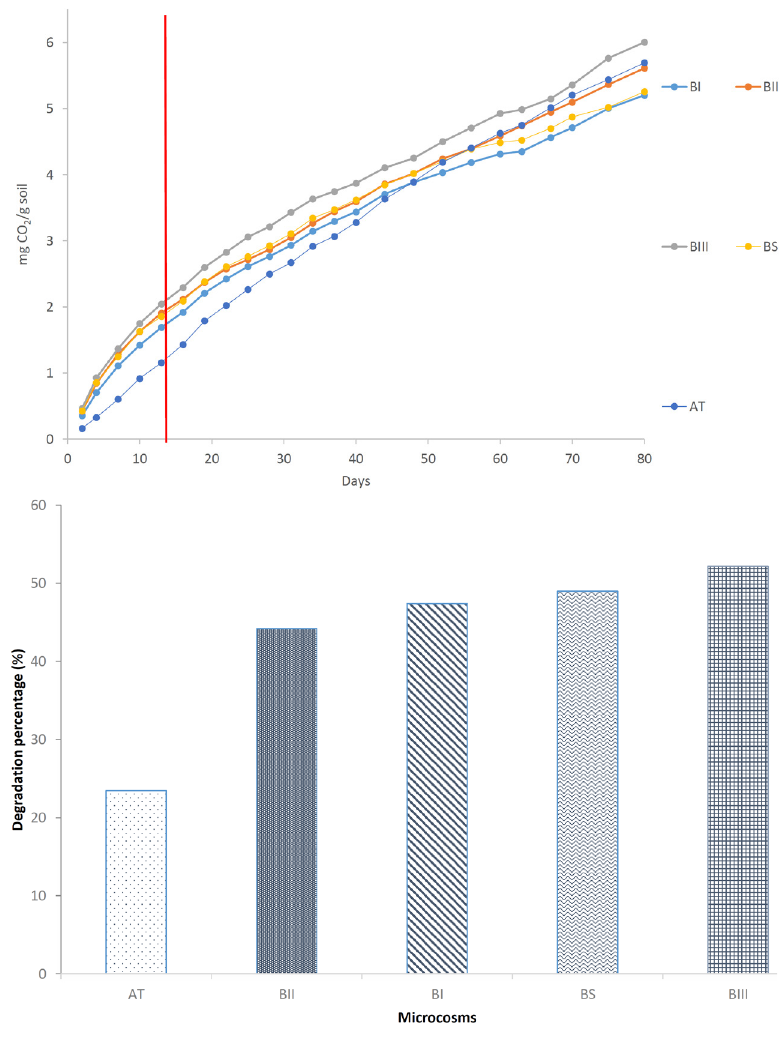
Figure 4. (a) Respirometry results for microcosms essays, (b) The TPH degradation percentage in the microcosms